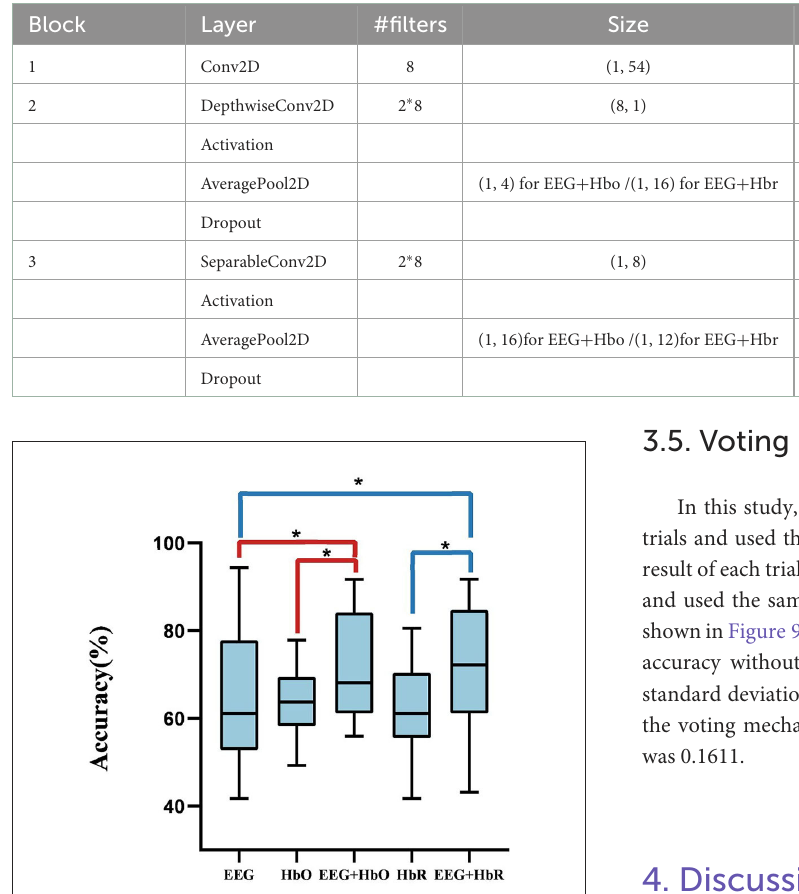
FIGURE8 The comparison between unimodality and bimodality. A P- value of < 0.05 and the performance of bimodal fusion is significantly superior to that of